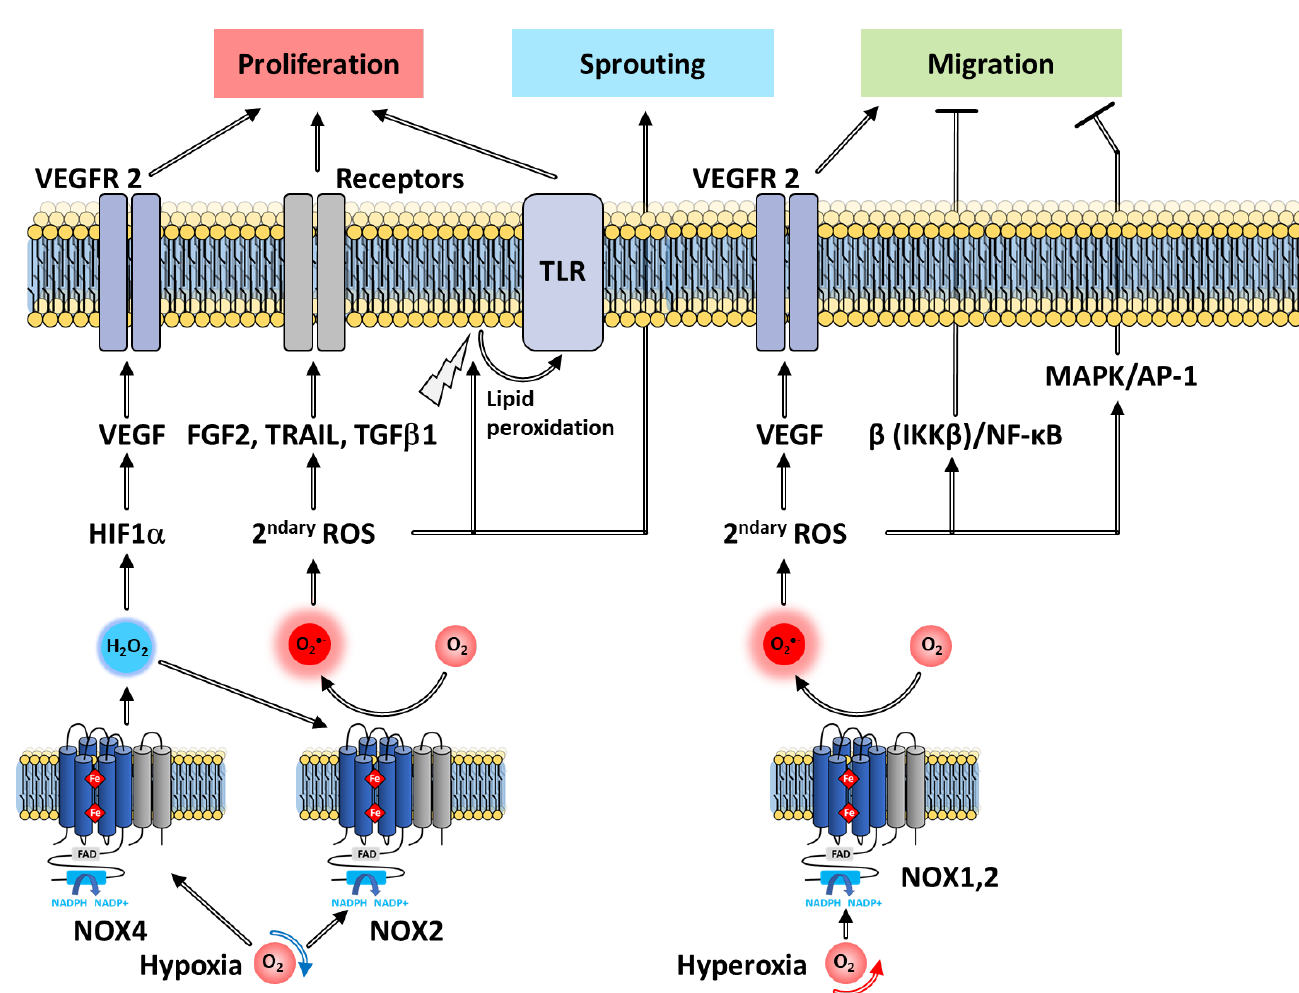
Figure 17. Regulation of angiogenesis steps by NOX. Hypoxia conditions activate NOX4 and NOX2, inducing the production of ROS and thereby enhancing VEGFR2 signaling and angiogenesis in ECs. Nox4-derived H 2 O 2 also activates NOX2 to promote superoxide production. NOX-mediated ROS promotes lipid peroxidation activating TLR, which regulates cell proliferation. Hyperoxia conditions activate NOX1, leading to the elicitation of cell migration through the VEGF pathway. The ROS-mediated β (IKK β )/NF- κβ and MAPK pathways can inhibit this